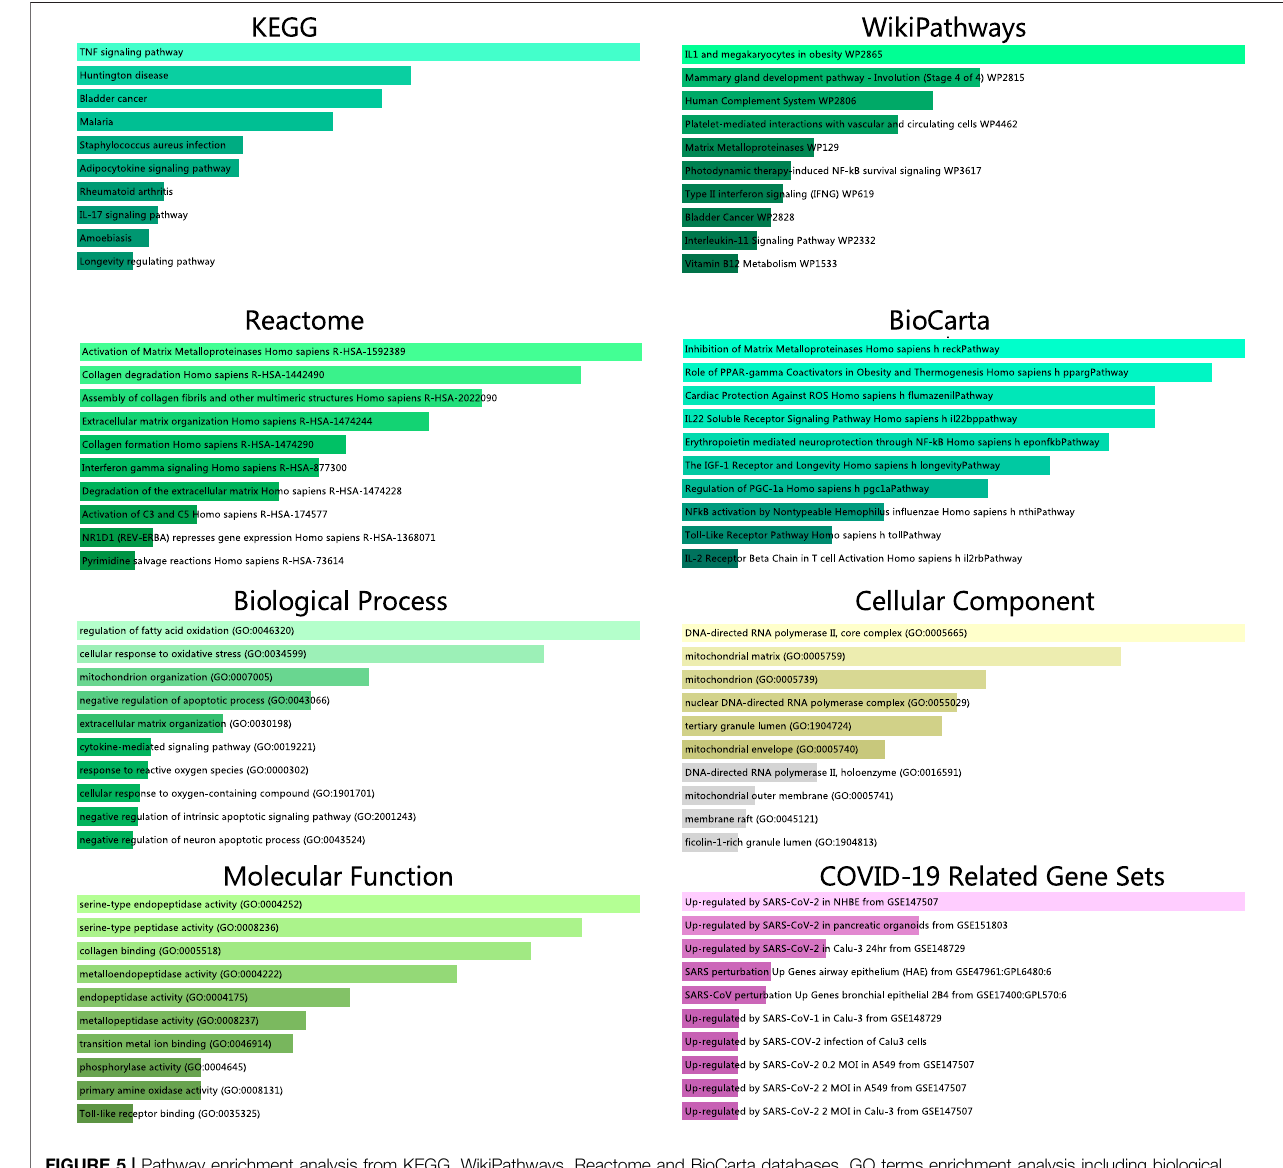
Frontiers in Pharmacology |